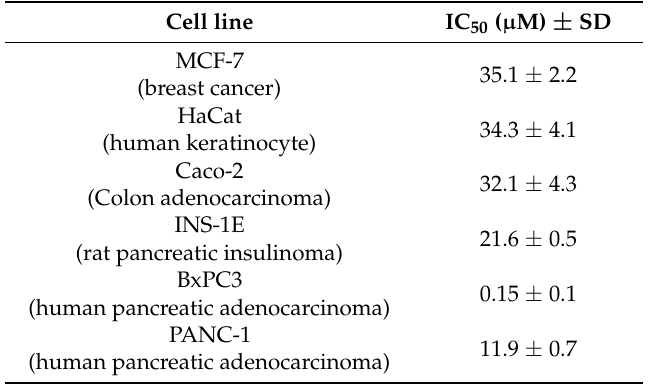
Table 1. IC 50 ( ± Standard deviation (SD)) values of different cell lines—cytotoxicity